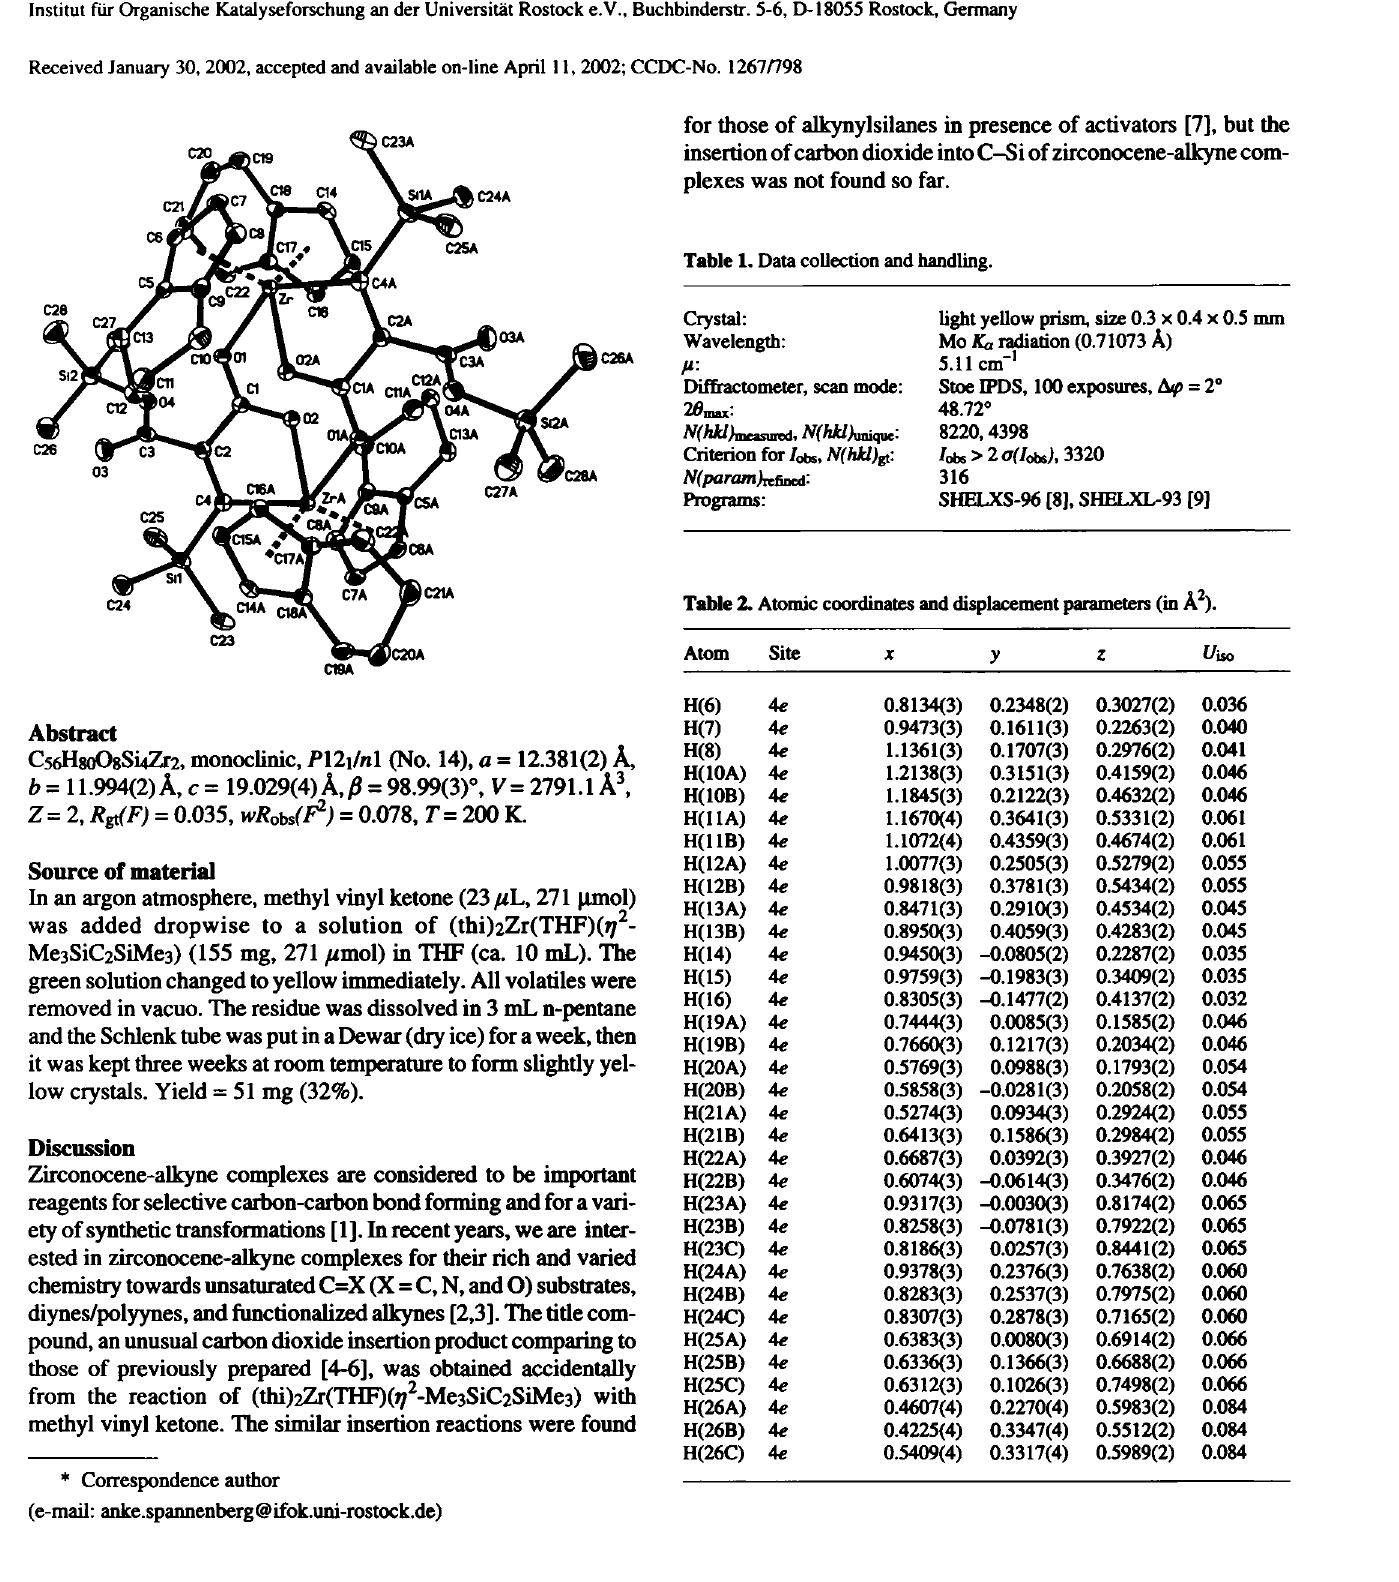
Table 1. Data collection and handling.